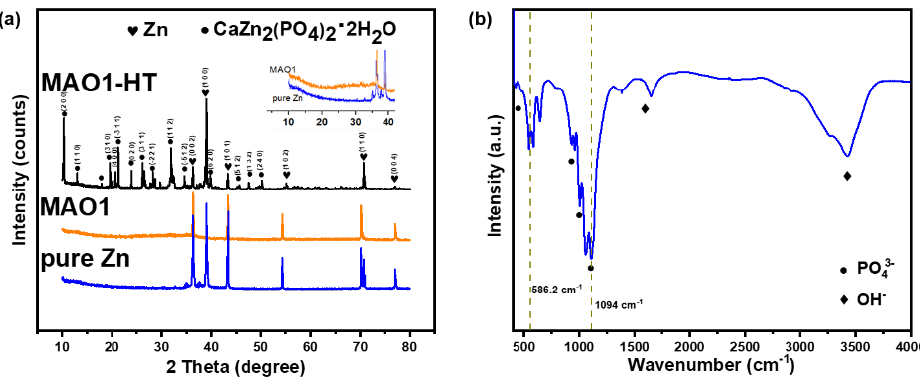
Figure 2. ( a ) XRD patterns of pure Zn, MAO1, and MAO1 − HT. ( b ) FT-IR spectra of the MAO1−HT